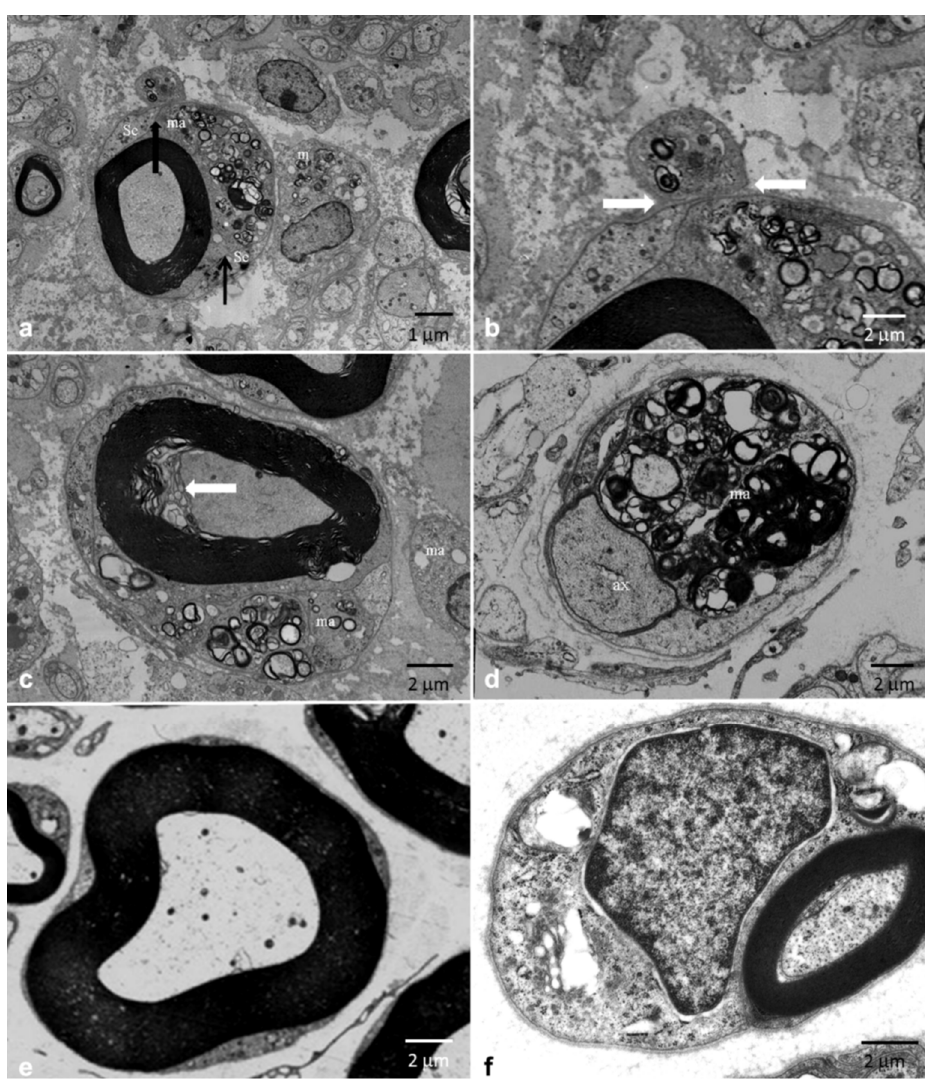
Figure 6. Sural nerve biopsy from a 37-year-old man with “typical” CIDP ( a – d ) and normal age-matched controls ( e , f ). Electron microscopy. Macrophage-mediated demyelination. ( a ) A fiber with normal myelin appearance wrapped in a macrophage (ma) is observed; in the macrophage’s cytoplasm, there are numerous myelinated figures, expression of an early phase of the demyelination process. The arrows indicate the demarcation between the cytoplasm of the Schwann cell (Sc) and that of the macrophage. Separated from the fiber, another macrophage (m) participates in the “digestion” of the myelin. ( b ) Greater enlargement of a detail of (a). The macrophage has broken off the basement membrane (arrows) to attack the myelin. ( c ) Myelin begins to decompact and has a “beehive” (arrow) appearance. Also, in this case, the macrophage (ma) actively participates in the process of destruction of the myelin sheath. ( d ) Axon (ax) appears completely devoid of the myelin sheath. Also, in this case, there is a macrophage (ma) loaded with myelin debris. ( e ) Normal myelinated fiber. ( f ) Normal myelinated fiber surrounded by Schwann cell. Onion bulbs and inflammatory infiltrates, considered as other typical features of the disease, were present only in eight (18.6%) and two (4.7%) patients, respectively (Figure 7a–d).